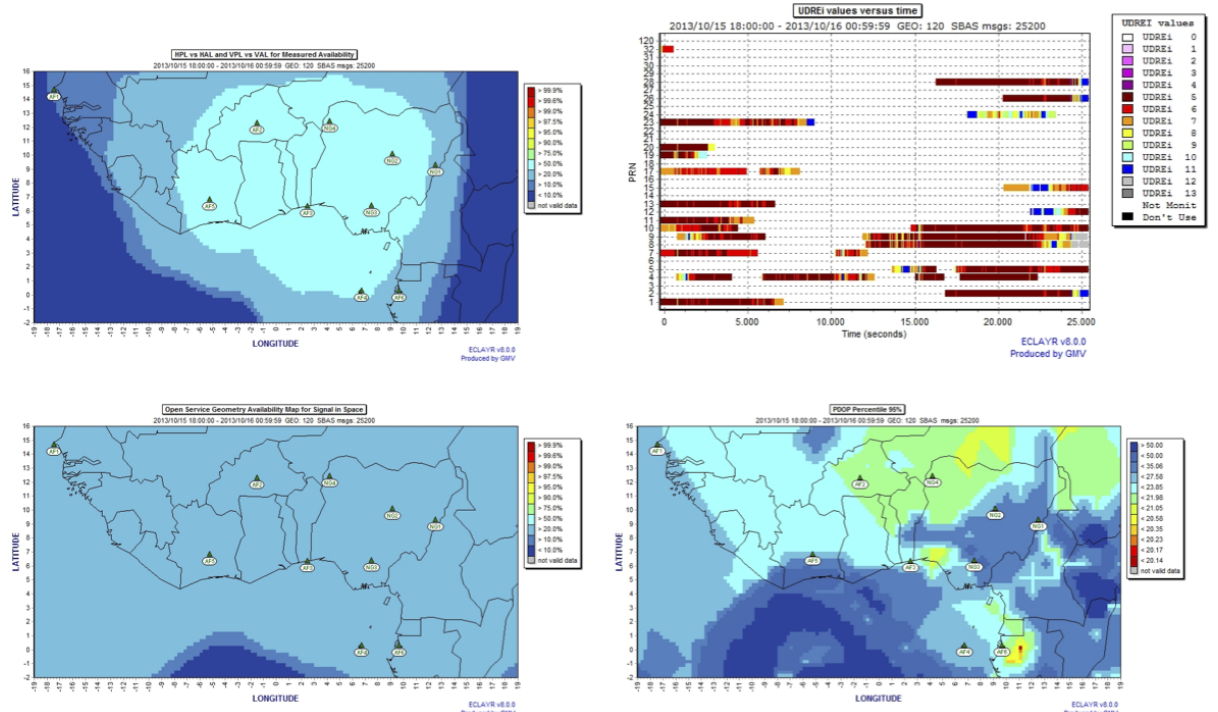
Figure 5. SBAS APV-1 availability map (upper left panel), user differential range error indicator (UDREi) (upper right panel), open service geometry availability map for signal in space (lower left panel) and positional dilution of precision (lower right panel) for 15 October 2013 when irregularities were not inhibited.